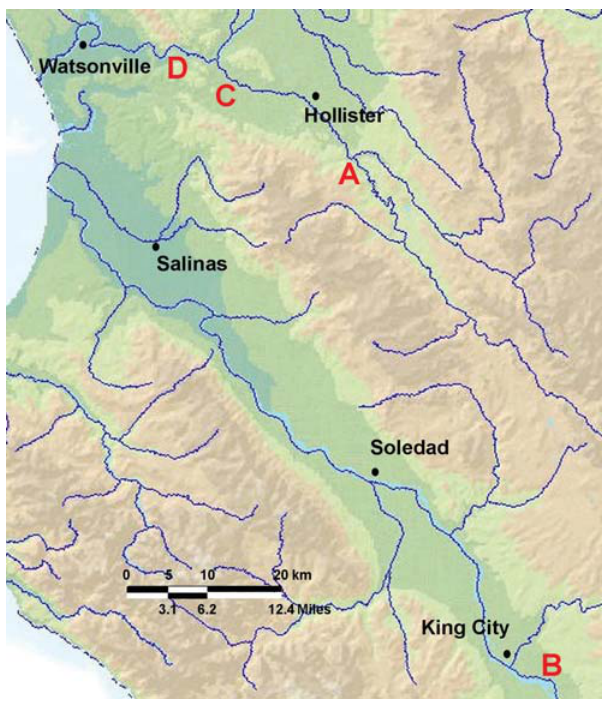
Figure 4. Map of Salinas and San Juan valleys showing the positions (A–D) of F/Rs implicated in the traceback investigations associated with the baby spinach outbreak 2006. Blue lines on the map are